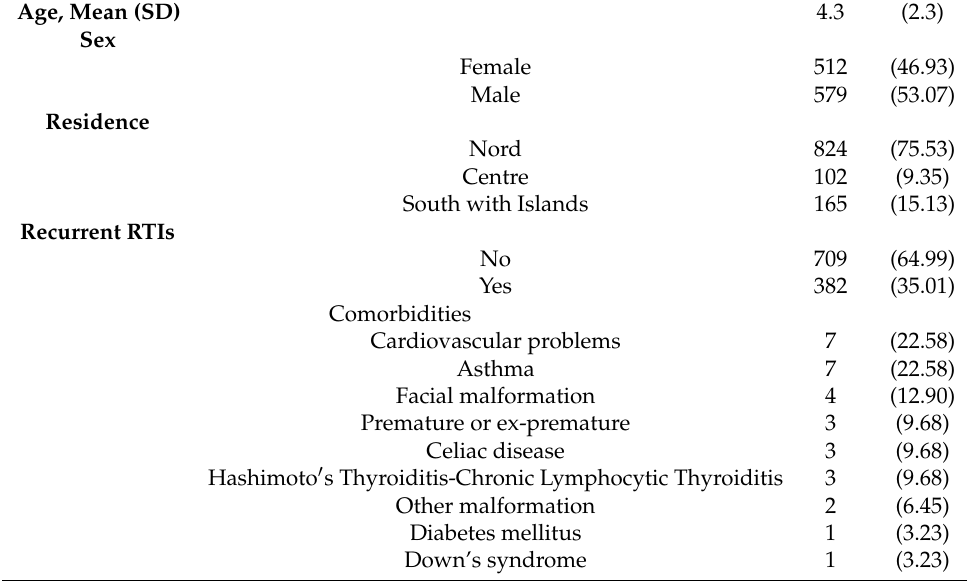
Table 1. Demographic and clinical characteristics of patients. Pedianet 2007–2017, N = 1091.